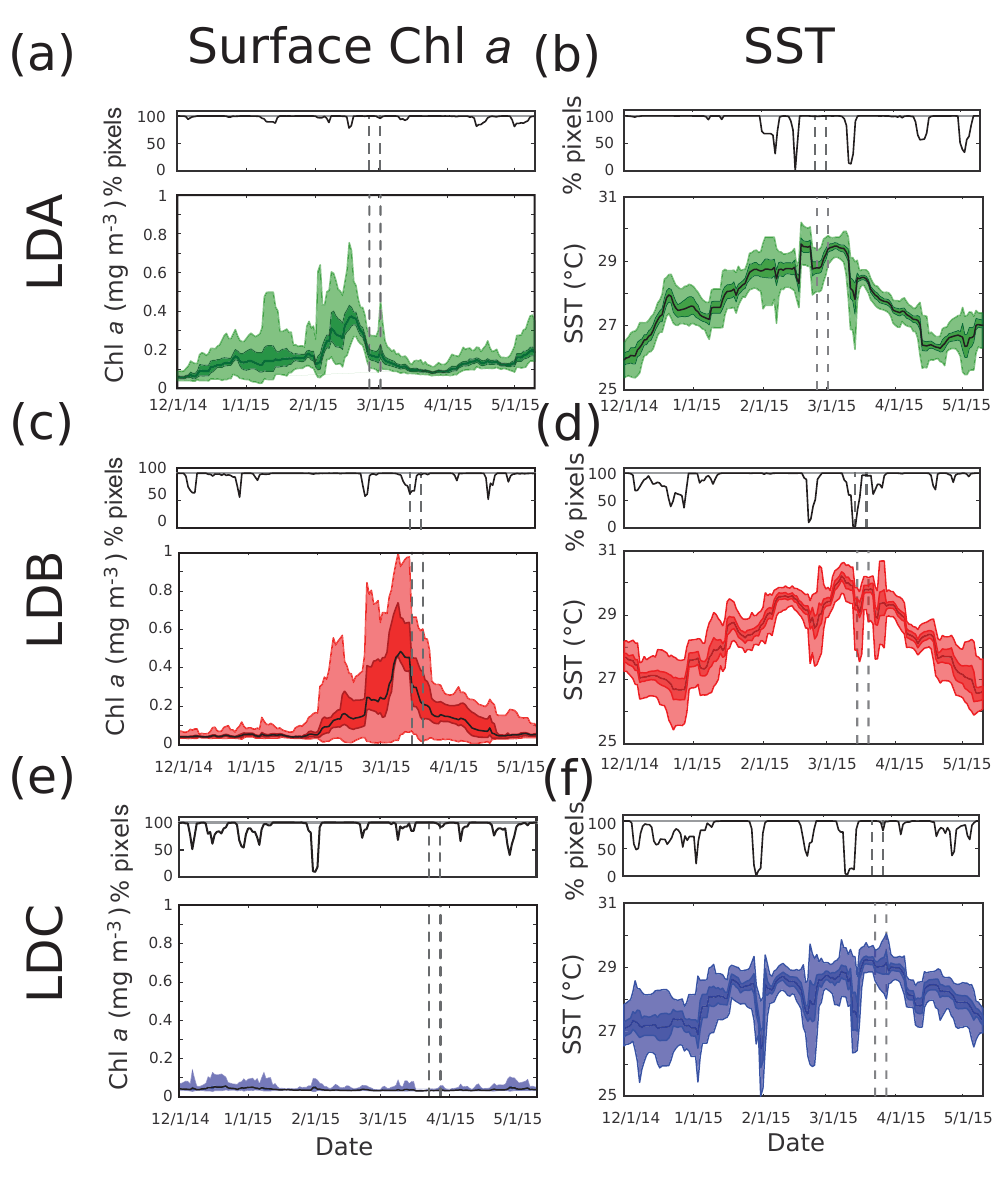
Figure 3. Time series of surface chl a and SST, respectively, for (a, b) LDA, (c, d) LDB, and (e, f) LDC. Intervals of LD sampling shown with gray dashed lines. Mean values are plotted in black, with darker shades representing the 25–75% interval and lighter shades for 1–99%. Subpanels above each time series depict the % of pixels with data. All data come from within the 120km × 120km squares shown in Fig. 2.